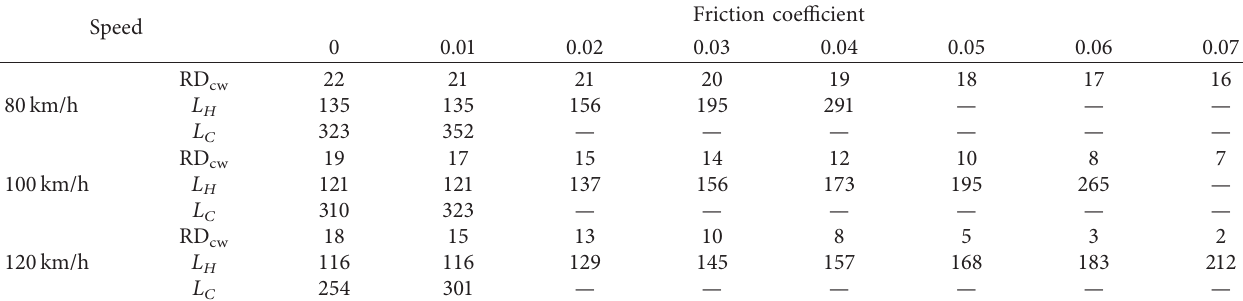
Table 3: Critical rutting length and water depths with speeds